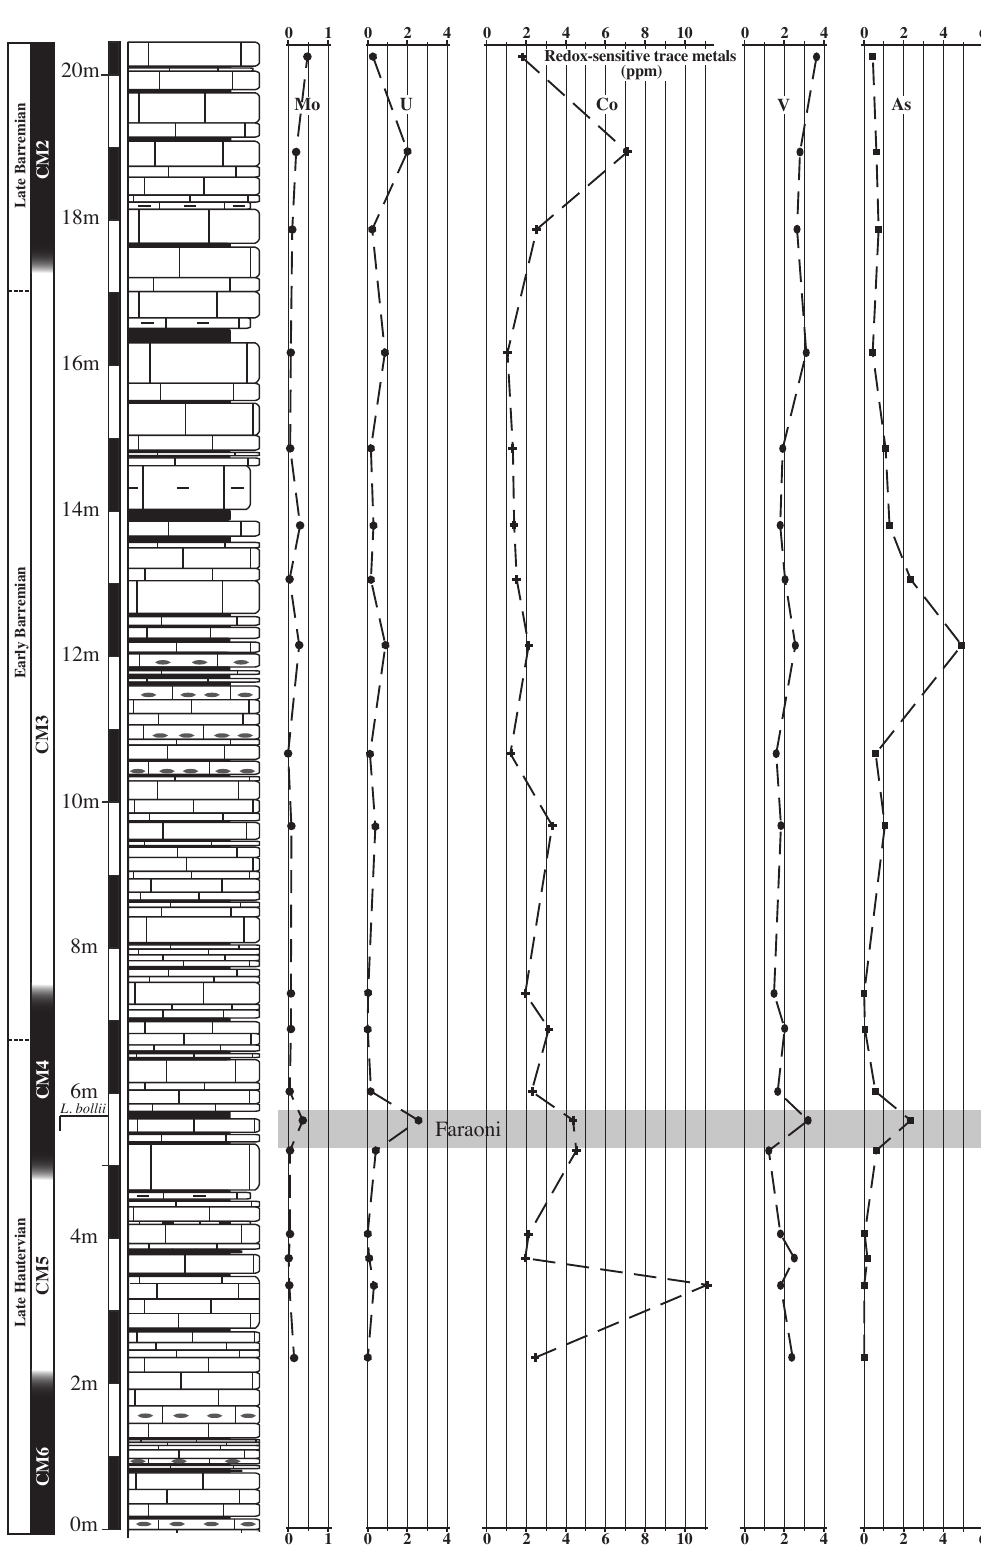
Föllmi et al., Fig. 7 Fig. 7. The Breggia section: redox-sensitive trace-metal distributions for molybdenum (Mo), uranium (U), cobalt (Co), vanadium (V) and arsenic (As) in carbonate